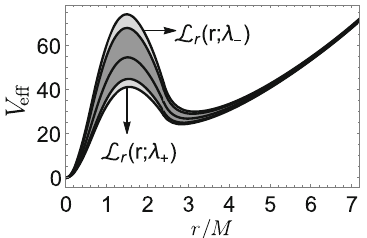
Fig. 6 The effective potential L r for allowed values of the parameter λ . In the shaded area, we find all possible effective potentials for the allowed values of lambda and θ = π/ 2. In the darker region, there are effective potentials with allowed values λ and θ = π/ 4 or 3 π/ 4, and the curve in the middle of the dark region plots the effective potential as θ approaches the